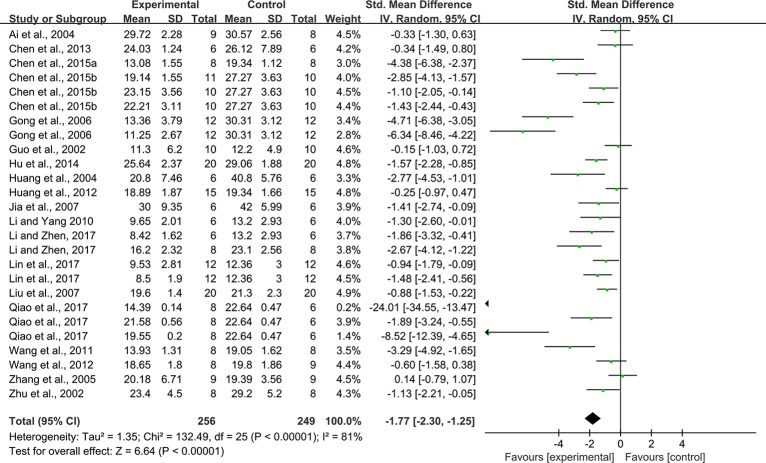
Pooled estimate of blood glucose with rhein.